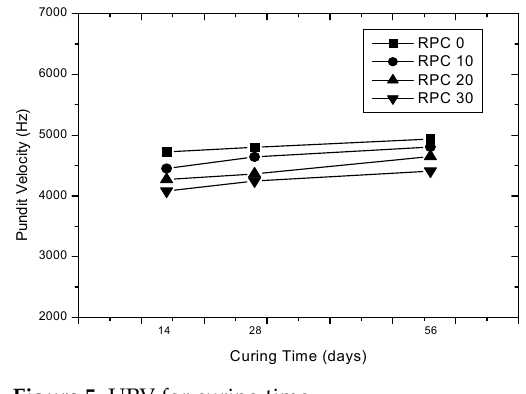
Figure 5. UPV for curing time.